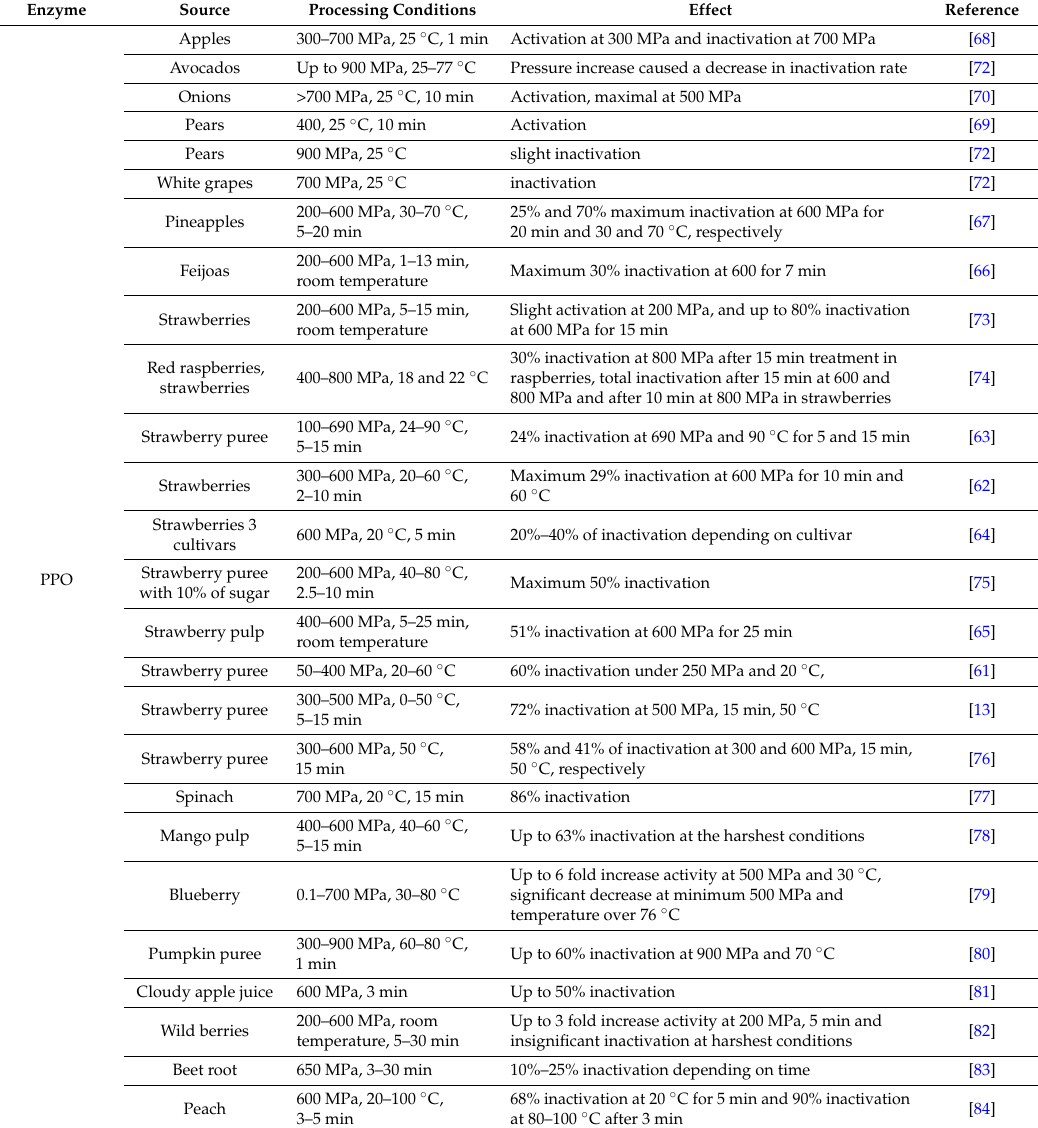
Table 1. Effect of HPP on the stability of selected fruit and vegetable